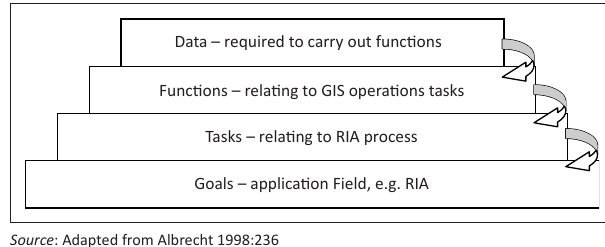
FIGURE 2: The geographical information